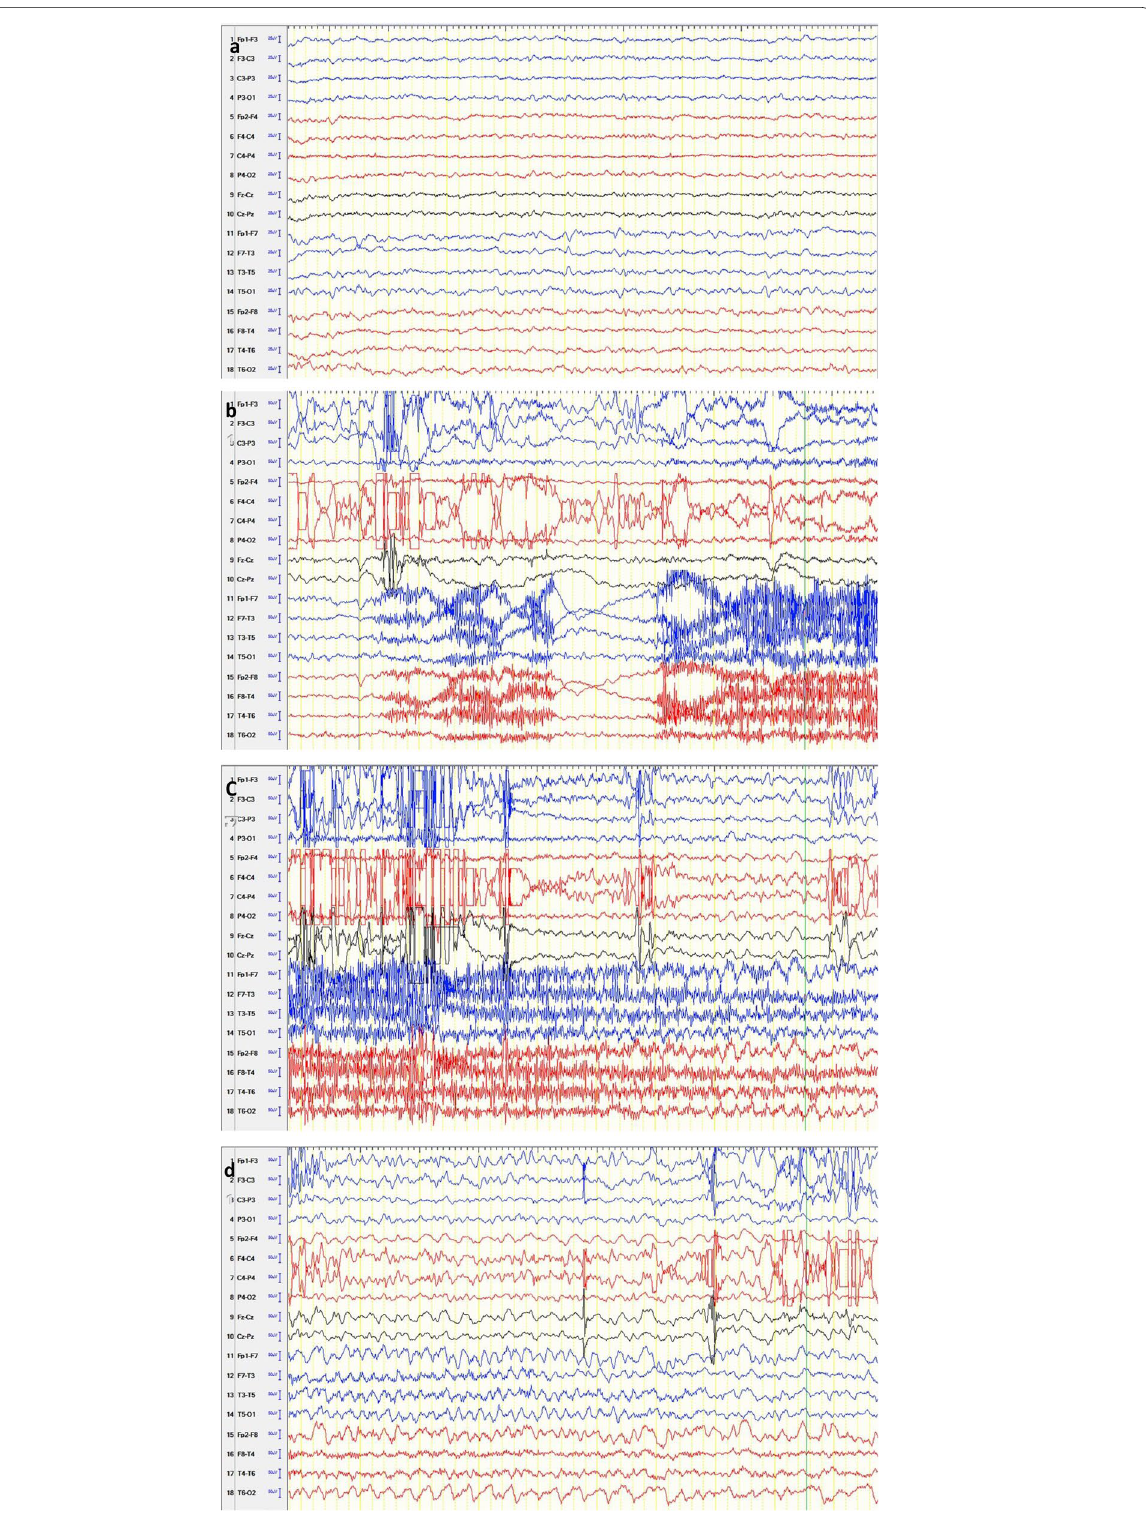
Fig. 1 Presurgical phase 1 EEG results. a . Interictal EEG showing sharp waves in the left anterior temporal region. b ‑ d . Ictal EEG showing rhythmic discharges over the left anterior temporal region. Bipolar montage,